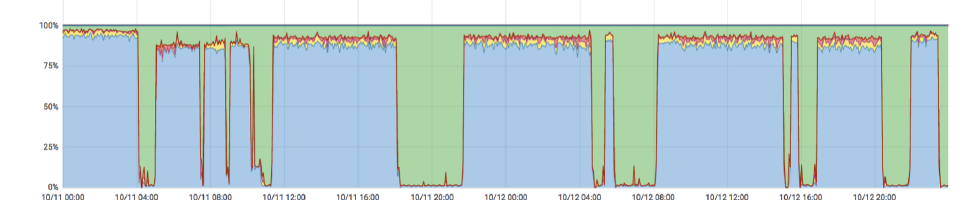
Figure 6: CPU utilisation on a typical worker node with the ARC pilot mode. The green areas show the CPU idle time, and the blue the execution of jobs.